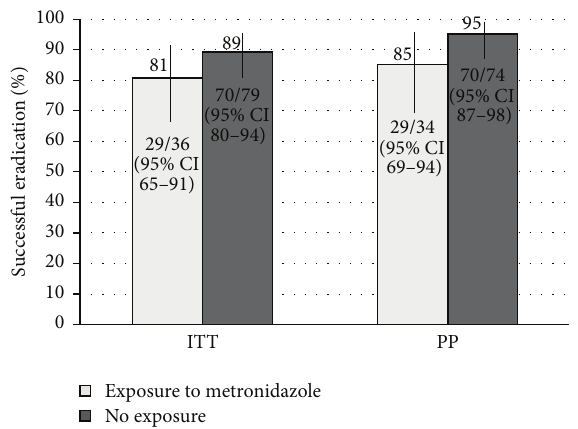
Figure 7: Eradication with bismuth quadruple therapy based on previous exposure to a metronidazole-containing H. pylori treat- ment. Risk difference: 10% (PP, 95% CI: − 2–25) and 8% (ITT, 95% CI: − 5–25).